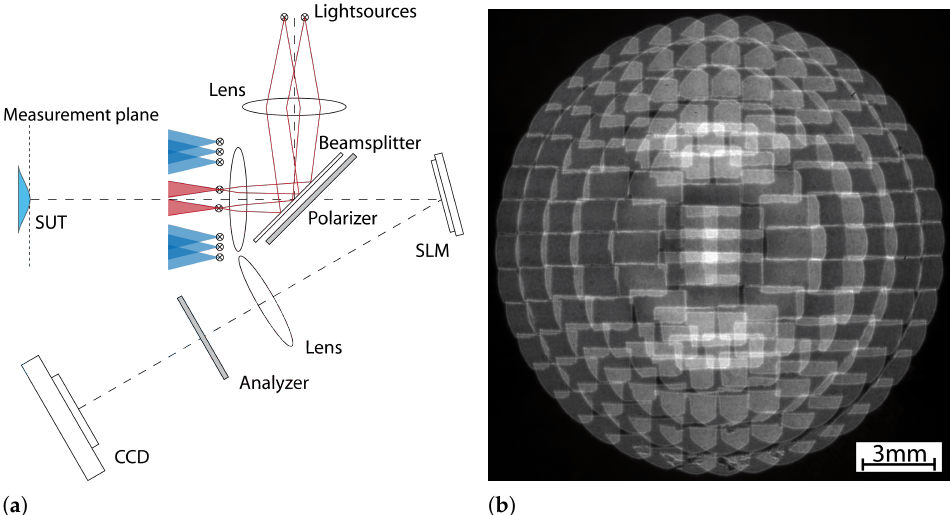
Figure 6. Multiple Aperture Shear Interferometry (MArS): ( a ) The setup consists of a shear interferometer and multiple independent light sources for illumination (illumination apertures). Some of the illumination apertures have to be guided through the observation lens in order to access the entire surface under test (SUT). ( b ) Intensity image recorded by the camera with a spherical mirror as the SUT. The illumination apertures appear as rectangular areas, where one aperture corresponds to one light source. Reprinted with permission from Reference